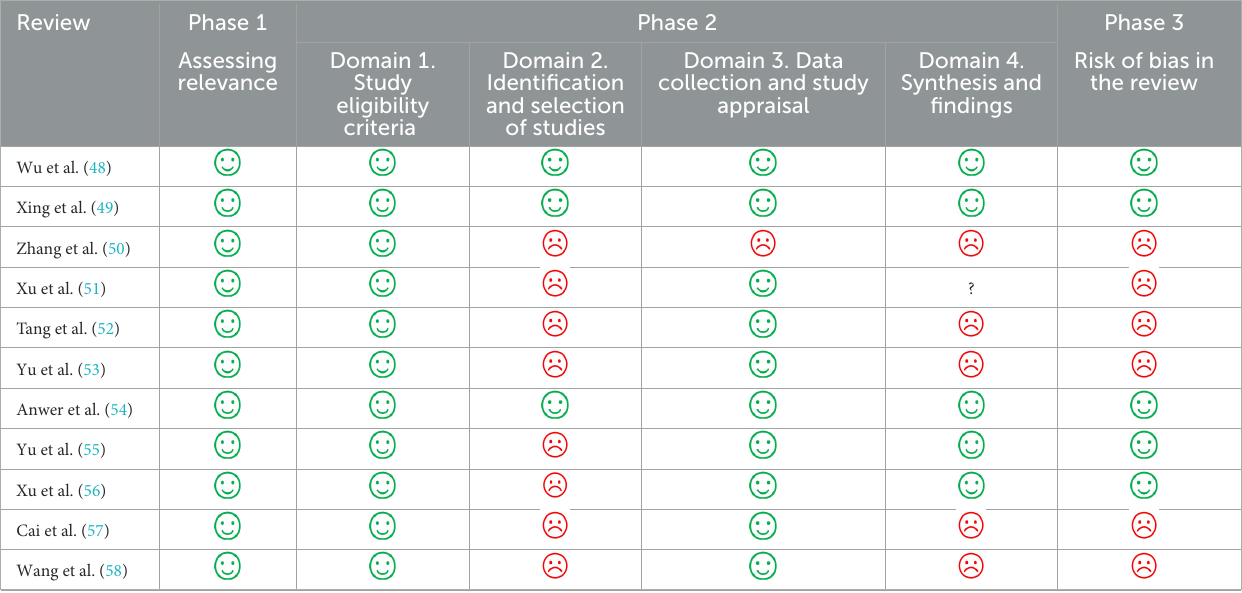
TABLE 4 Results of ROBIS